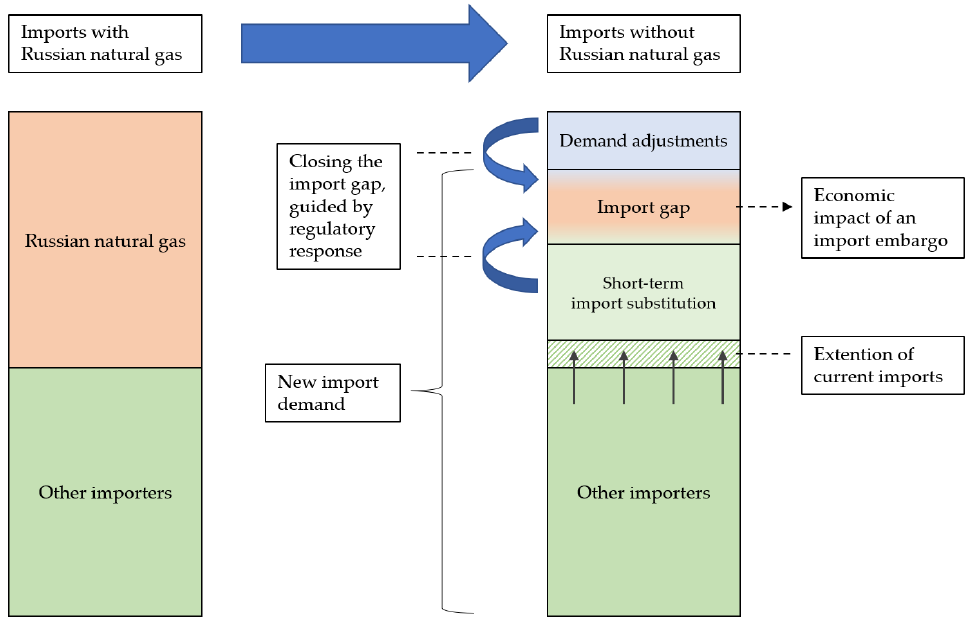
Figure 1. Methodology framework: from an import portfolio with Russian natural gas to an import portfolio without Russian natural gas through import substitution and demand adjustments.